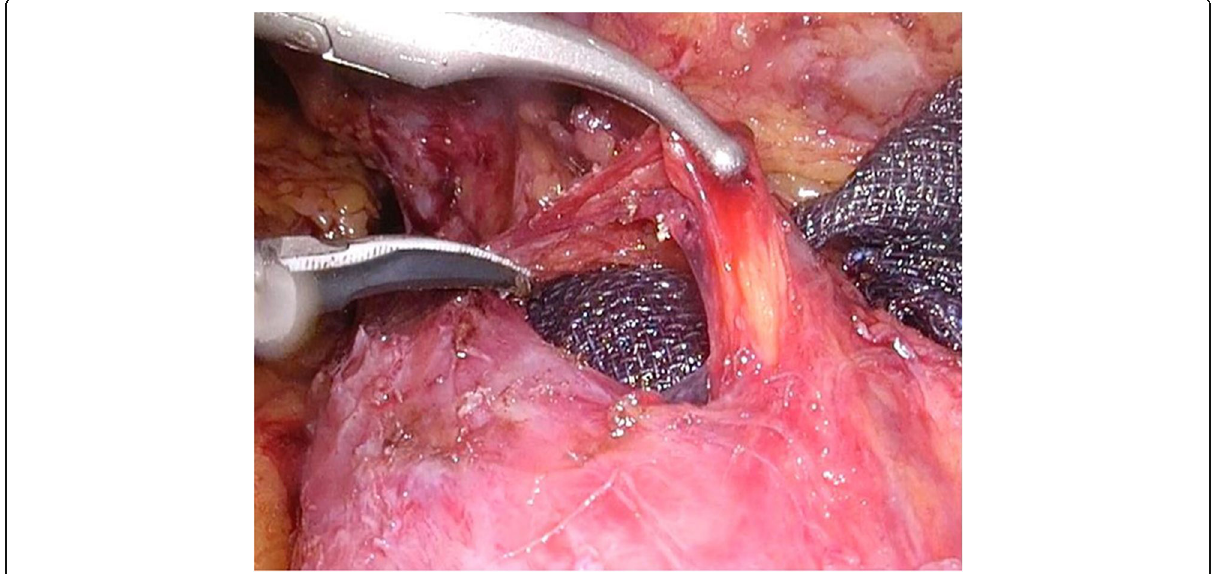
Fig. 3 Breaking up adhesions from the ventral side of the duodenum revealed the location of the duodenal